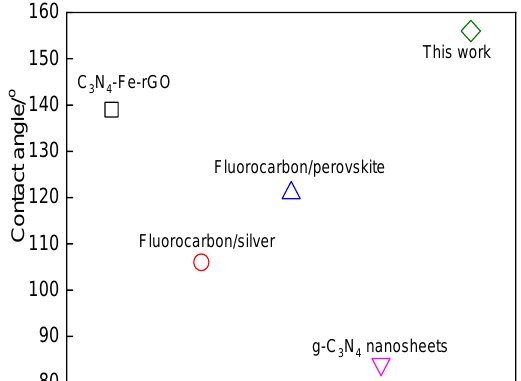
Figure 8. The recent literature review on g-C 3 N 4 nanosheets [47], fluorocarbon/silver [48], fluorocar- bon/perovskite [49], C 3 N 4 -Fe-rGO [50] and related water contact angle of superhydrophobic perfor- mance.